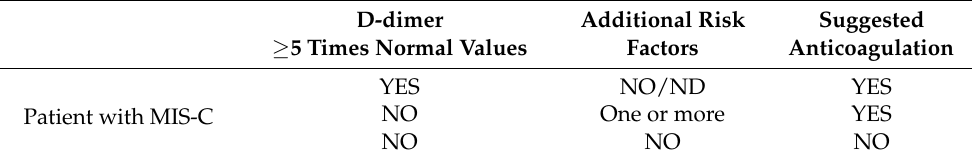
Table 8. Stratification of thromboembolic risk in patients with multisystemic inflammatory syndrome (MIS-C) in relation to D-dimer values.